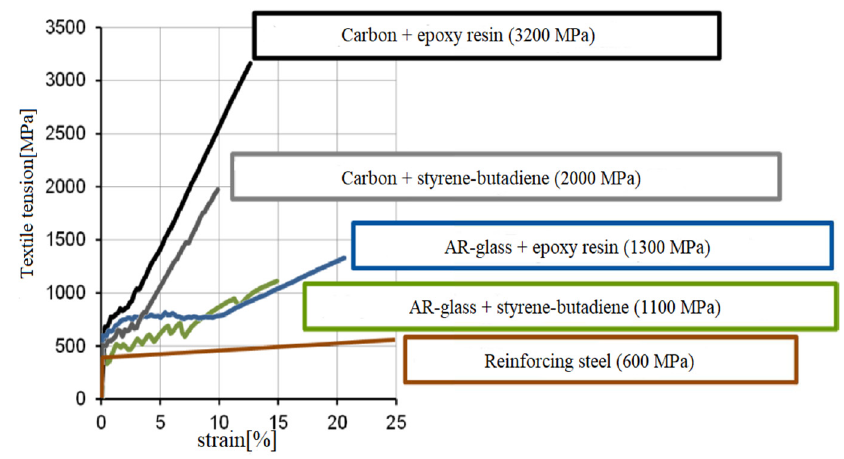
Figure 8. Comparison of different textiles and coatings under tensile stress [48].